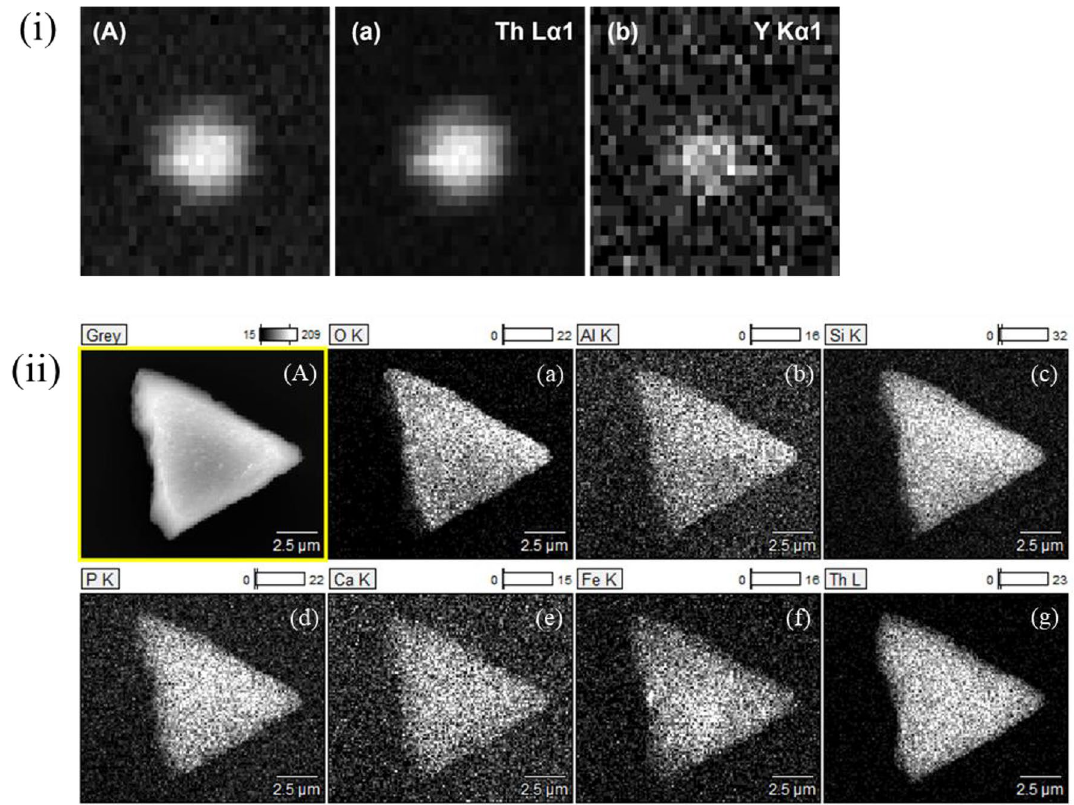
Figure 3. (i) µ-XRF maps of the Th-silicate particle ( A ) showing the total fluorescence and the fluorescence lines of Th ( a ) and Y ( b ) in greyscale (maps: 82.5 µm in width, 67.5 µm in height). (ii) SEM image of the Th-silicate particle ( A ) and corresponding SEM–EDX elemental maps for O, Al, Si, P, Ca, Fe, and Th ( a–g ) in of Fe, Al, and Si (Fig. 2(B-II), Table 2). This particle further contains Pb and possibly low levels of Cu and Ni (Fig. 2(B-III)). The molar ratio of 5.7 from O:(Th + Ce) indicates the presence of different oxidic phases in these samples. Concerning the presence of phosphates, Fe-oxides, and silicates, the O:(Th + Ce) ratio is too high for the presence of only Th/CeO 2 . The SEM–EDX analysis would rather point to some kind of Th/Ce(OH) 4 or Th/ CeO(OH) 2 . This would also be more consistent with the XANES spectra, and therefore, we conclude that the particle is dominated by (hydr)oxides, presumably Th-oxide or hydroxides mixed with Ce-oxide/hydroxide as the major component. This is further confirmed by the distribution of Th and Ce in the fluorescence maps (Fig. 4(i)B and 4(i)a, b), presenting a significant correlation (i.e., ρ = 0.970; see Supplementary Fig. S2online). In fact, literature provides evidence for (Th, Ce)O x (OH) y solid solutions owing to the comparable ionic radii 40,41 of Th(IV) and Ce(IV). SEM–EDX maps are shown in Fig. 4(ii)B and 4(ii)a-i. Particularly, Fig. 4(ii)f and i show an inhomogeneous distribution of Fe compared to Th, i.e., higher density areas towards the lower corner, suggest- ing iron oxide phases that are slightly depleted in Th, attached to the (Th, Ce)O 2 particle covering a part of the grain. The seemingly homogeneous Fe-distribution in the XRF maps (Fig. 4(i) a, c) and significant correlation with Th (i.e., ρ = 0.806; see Supplementary Fig. S2 online) are due to the absence of adequate spatial resolution. A small clay mineral flake was for instance identified (Fig. 4(ii) b and c) on the bottom corner of the particle. Relatively consistent surface distribution of Ce can be seen in the SEM–EDX map (Fig. 4(ii)h), matching that of O and to a lesser extent to traces of Si and Al despite the mapping shadow effect, and associated clay fractions (Fig. 4(ii)a-c). The slightly weaker intensities of Th and Ce signals in the area where the Fe signal is enhanced could be interpreted as the Th/Ce-oxide particle being covered by iron oxide. Both Ce and Th are related to a small extent (0.65 < ρ < 0.85; see Supplementary Fig. S2 online) to traces of Ti and Pb (Fig. 4(i)d, e), indicating that the correlation analysis mostly reflects counting statistics. In summary, the collected data show that the natural Th-oxide particles are not pure ThO 2 (thorianite) but presumably consist of a (Ce, Th)oxyhydroxide solid- solution covered by accessory clay minerals and Fe-oxide phases, including traces of P, Ti, Mo, and potentially also Ce (Fig. 4(ii)d, e, g, and h). Finally, the ~ 50 µm sized particle (i.e., identified as a Th-phosphate-containing particle, depicted in Fig. 2(C- I)) is found to have lower Th content (~ 1 wt.%), according to SEM–EDX, compared to the two previously dis- cussed particles, but contains significant amounts of P and considerable amounts of light REEs (Table 2). The total REE (La, Ce, Nd, Pr) content amounts to ~ 44 wt.% (Fig. 2(C-II), Table 2), comparable to ~ 45 wt.% in the RC-monazite. Hence, soil particle C is depleted in Th (stoichiometric composition: (Ce 0.43 , La 0.25 , Nd 0.16 , Pr 0.04 , Th 0.01 , Ca 0.10 )(P 0.98 , Si 0.02 )O 4 ), compared to the RC monazite from Brazil (stoichiometric composition: (Ce 0.41 ,